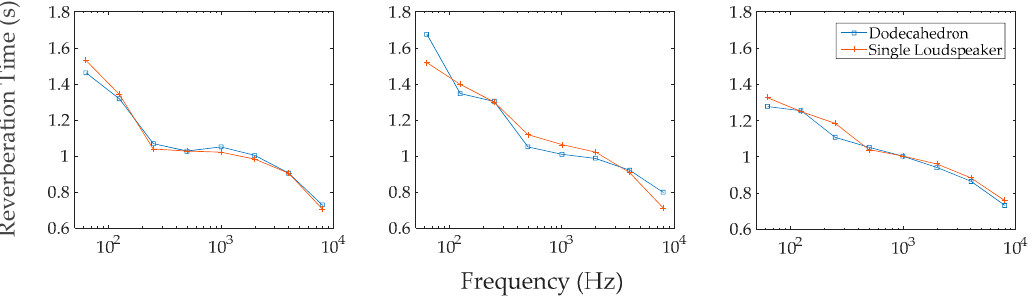
Figure 8. RT for points A, B and C in the amphitheater (from left to right respectively).